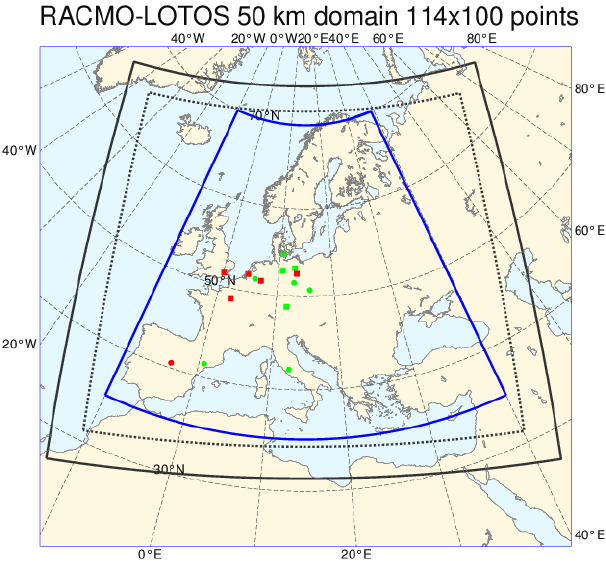
Fig. 1. RACMO domain in black, inner domain dashed, encom- passing the LOTOS-EUROS domain (in blue). Points indicate loca- tions that are used in the analyses: red markers indicate cities, green EMEP background